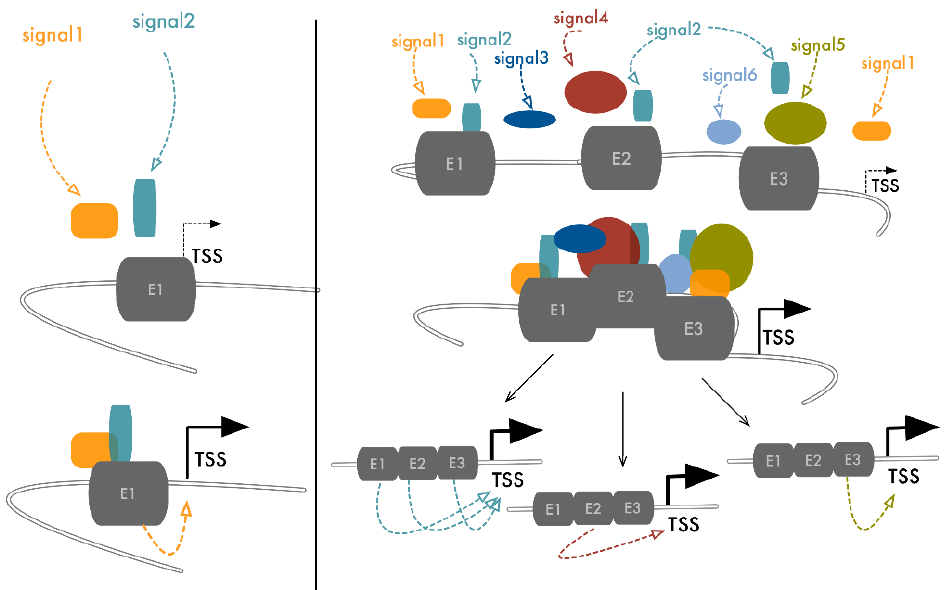
Figure 3. Either short-range or long-range ENHs’ interaction ensures multiple signals integrate. Binding of the TFs on a single ENH occurs upon reception of precise stimulatory signals. In a cooperative model in which multiple ENHs concur to the regulation of the same target gene, activation of just one of these elements propagates to the others, promoting the assembly of the transcriptional complex on TSS and activating transcription. In this way, the number of external signals that can activate the expression of specific target genes is amplified, improving the precision and robustness of gene modulation and the backup strategies for essential genes. This is particularly important, for example, in cancer, where cells depend on a selective panel of essential genes, the expression of which must be preserved from hostile microenvironmental perturbations.